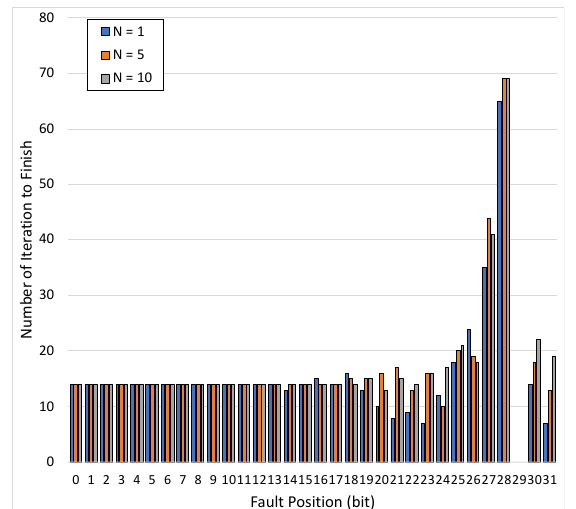
Figure 6. Number of iterations to finish a Newton–Raphson algorithm with faults injected on the N-th